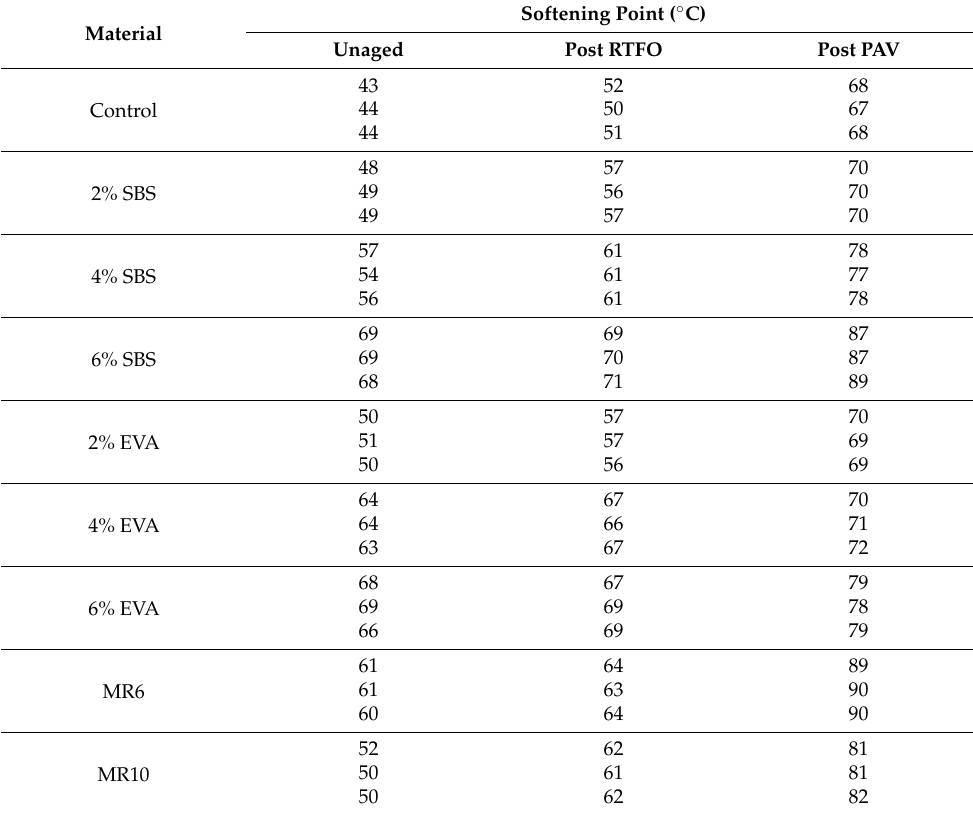
Table 4. Binder softening point